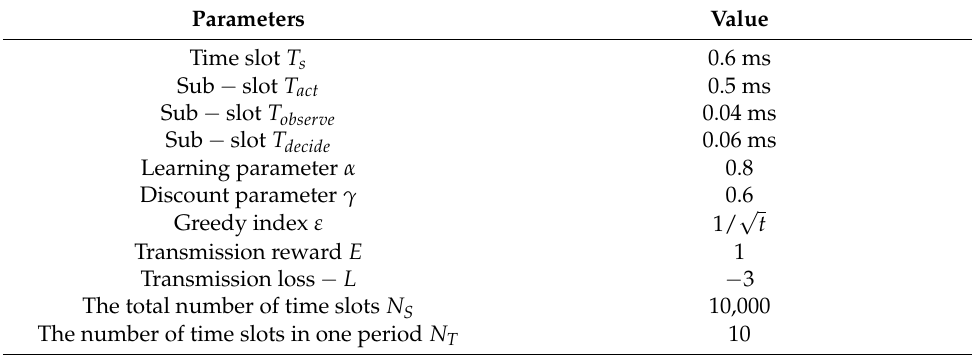
Table 1. Settings of model-related